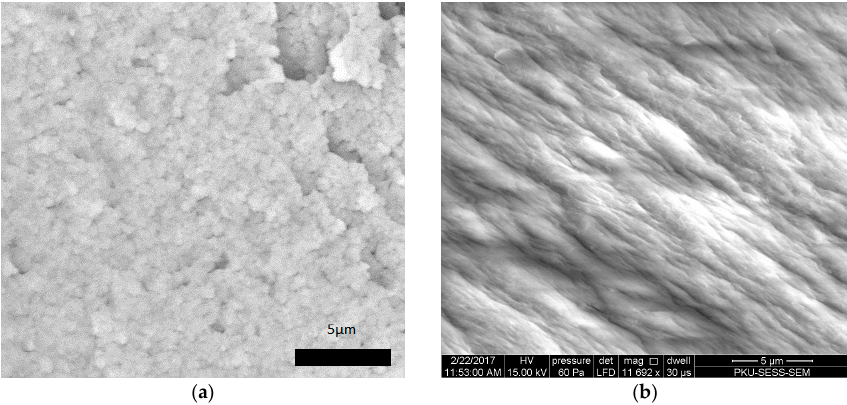
Figure 6. SEM image of HAP in bones of Cololabis saira . ( a ) micrograph of HAP particles observed on section surface perpendicular to the c -axis. ( b ) HAP clusters observed on elongation section surface parallel to the c -axis.